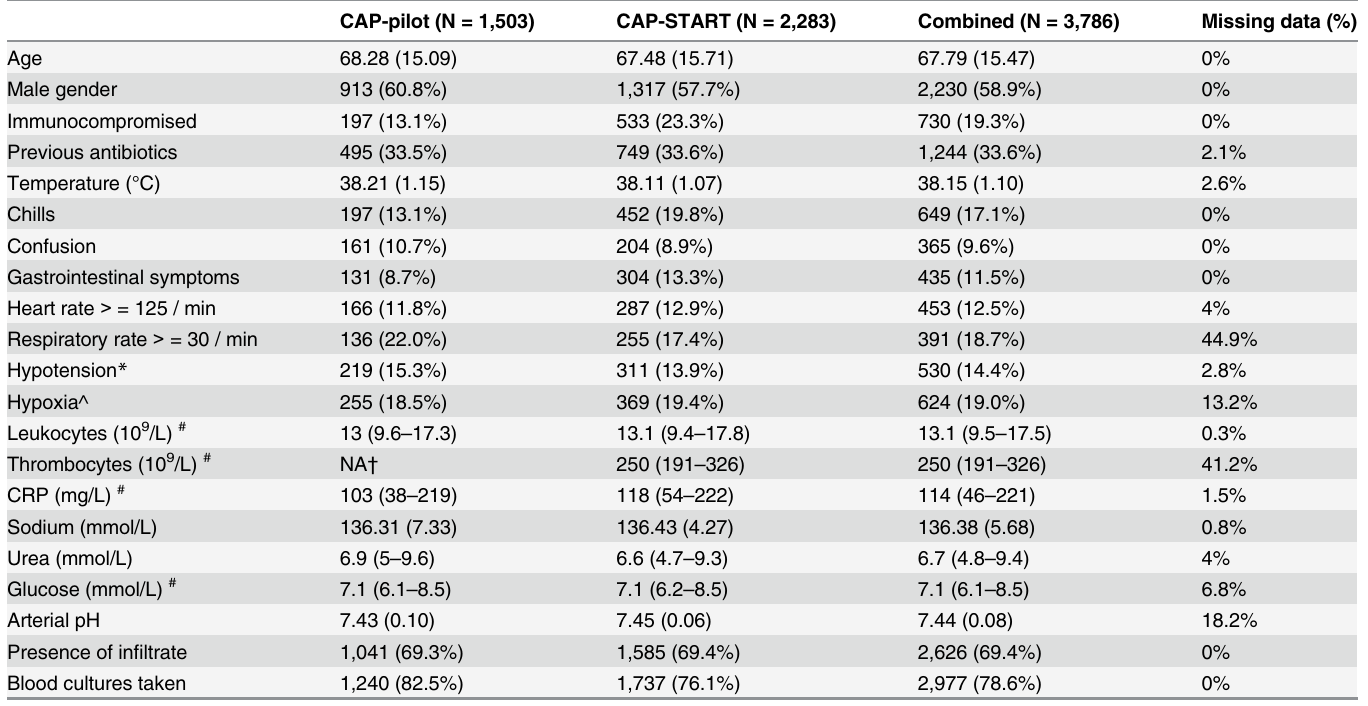
Table 1. Baseline characteristics of the study